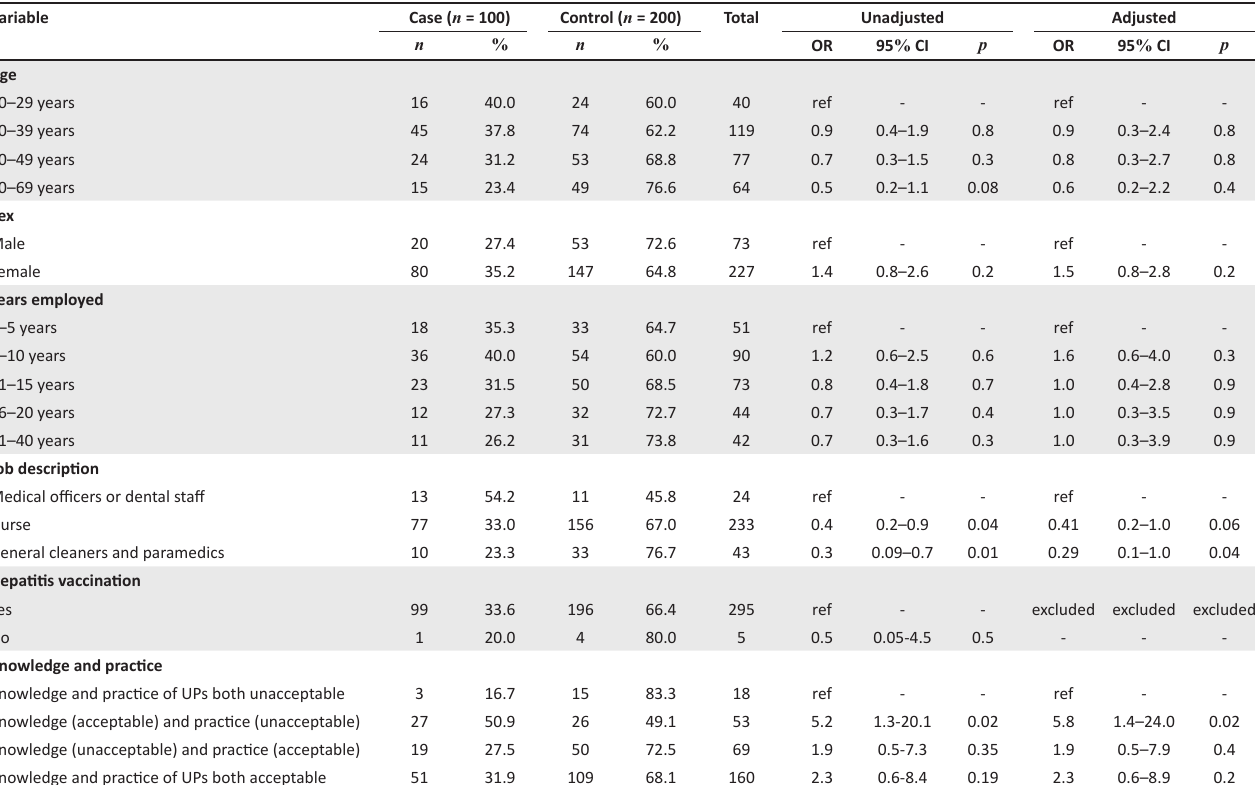
TABLE 4: Logistic regression for risks of needlestick injuries among health care workers ( N = 300).